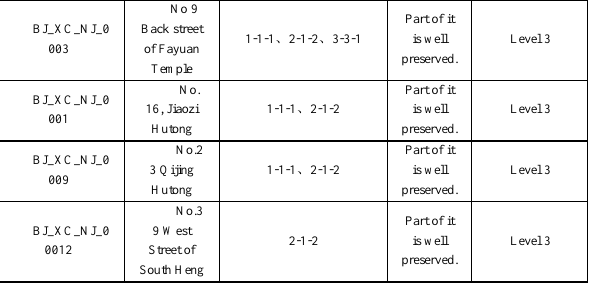
Table 5. Historical building protection classification